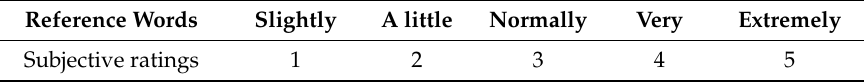
Table 7. Subjective annoyance results of sub-band audio